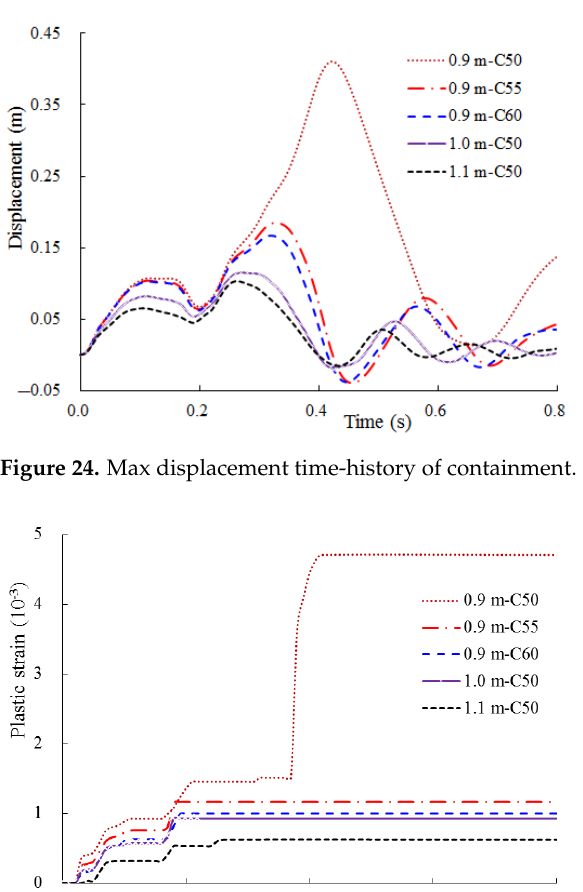
Table 4. The peak displacement, plastic strain, internal energy, and total energy.